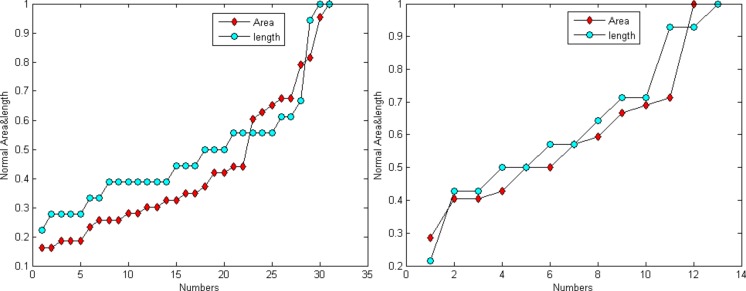
Distribution trend of the spine area and length of Figs. 4A and 4C.